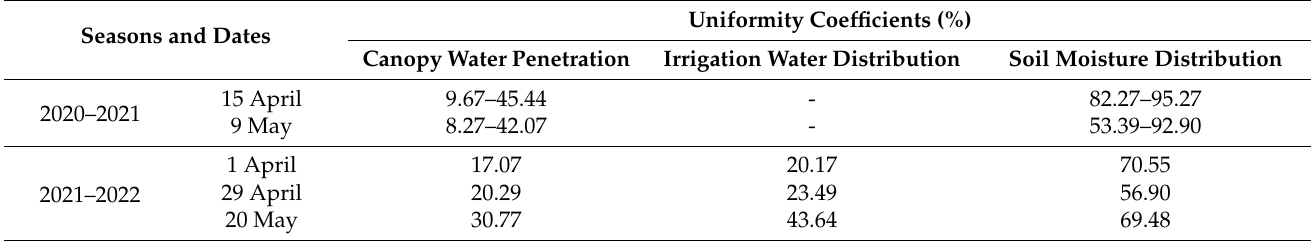
Table 3. Uniformity coefficients of canopy water penetration, irrigation water distribution, and soil water distribution for winter wheat in the growing seasons of 2020–2021, and 2021–2022, respectively.